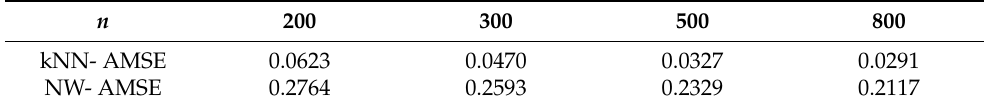
Table 1. The AMSE of the predicted response variables of the two methods under different sam- ple